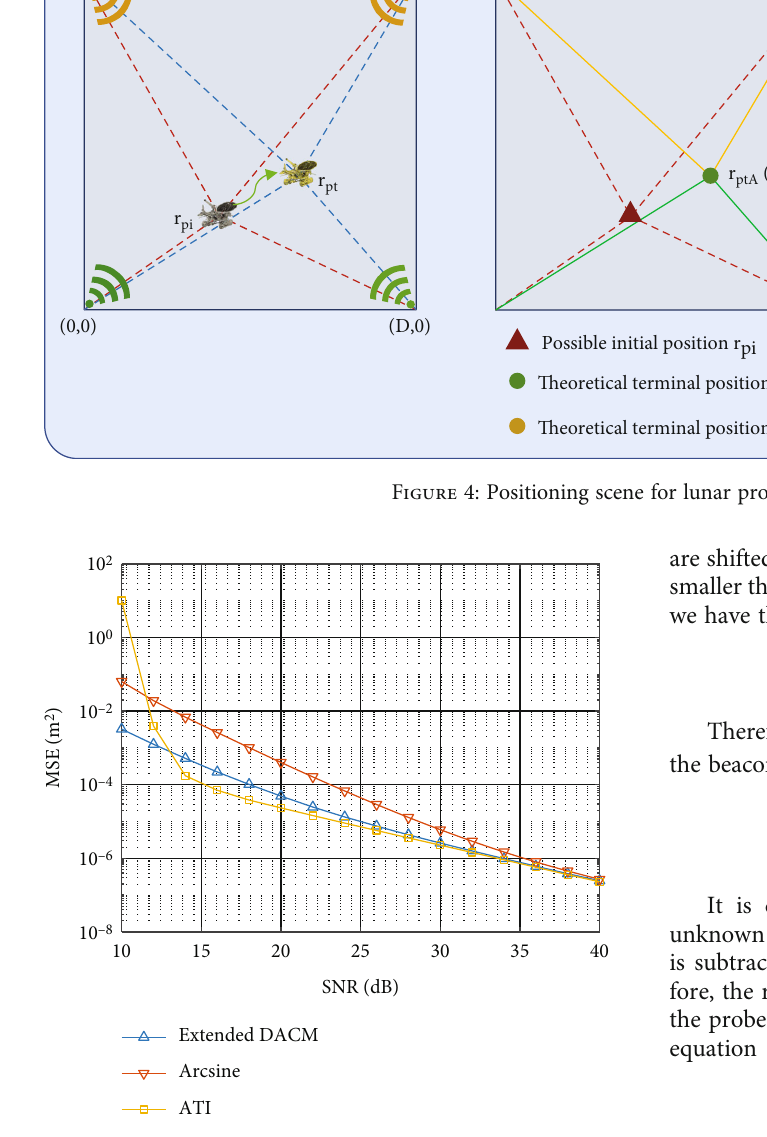
Figure 5: The MSE versus SNR after 10 4 Monte-Carlo simulations.